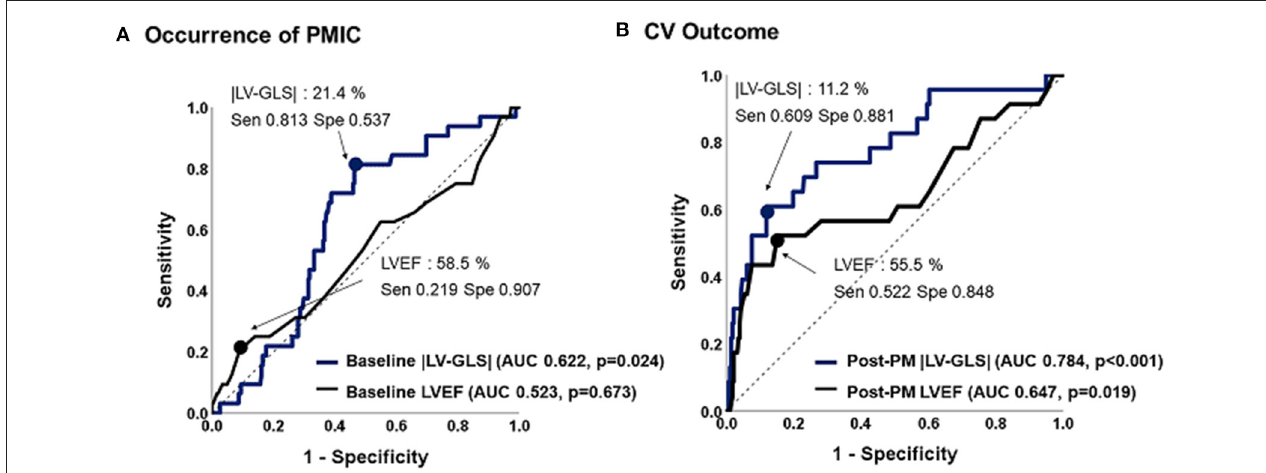
FIGURE 3 | Predictive values of |LV-GLS| and LVEF for occurrence of PMIC and CV outcome. (A) The |LV-GLS| on baseline echocardiogram revealed significant predictive value for occurrence of PMIC. (B) The |LV-GLS| on post-PM echocardiogram showed a better predictive value for CV outcomes than did LVEF. |LV-GLS|, absolute value of left ventricular global longitudinal strain; LVEF, left ventricular ejection fraction; PMIC, pacemaker-induced cardiomyopathy; PM, pacemaker; CV, cardiovascular.